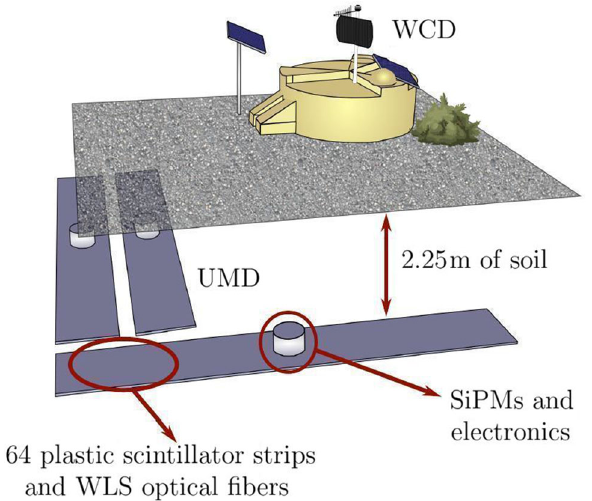
Fig. 1 Scheme of a water-Cherenkov detector (WCD) of the Pierre Auger Observatory with its three paired UMD modules. The modules lie 2 . 25m underground and have an area of 10m 2 each. They consist of 64 plastic scintillator strips embedded with wavelength-shifting (WLS) optical fibers. The SiPMs and the electronics are placed in the middle of the modules below an access tube. Figure adapted from Ref.